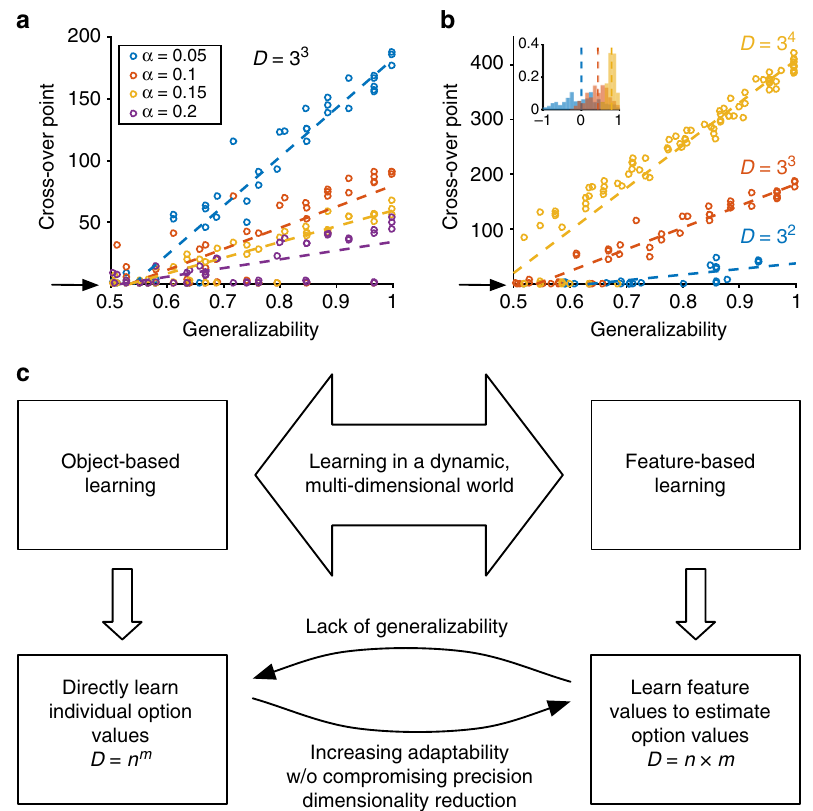
Fig. 1 A framework for understanding model adoption during learning in dynamic, multi-dimensional environments. a Cross-over point is plotted as a function of the generalizability index of the environment for different values of the learning rate. The cross-over point increases with generalizability and decreases with the learning rate. The larger learning rate, however, comes at the cost of more noise in estimation (lower precision). The arrow shows zero cross-over point indicating that the object-based learning is always superior for certain environments. b Cross-over point is plotted as a function of generalizability separately for environments with different values of dimensionality (for α = 0.05). The advantage of feature-based over object-based learning increases with larger dimensionality. The inset shows the distribution of the generalizability index in randomly generated environments for three different dimensionalities. c The object-based approach for learning multi-dimensional options/objects requires learning n m values, where there are m possible features and n instances per feature in the environment, whereas the feature-based approach requires learning only n × m values resulting in a dimensionality reduction equal to ( n m − n × m ). A feature-based approach, however, is bene fi cial if there are generalizable rules for estimating the reward values of options based on the combination of features ’ values. A lack of generalizability should encourage using the object-based approach. Finally, frequent changes in reward contingencies (dynamic environment) should increase the use of feature-based learning because it allows update of multiple features based on a single feedback and thus increases adaptability without compromising